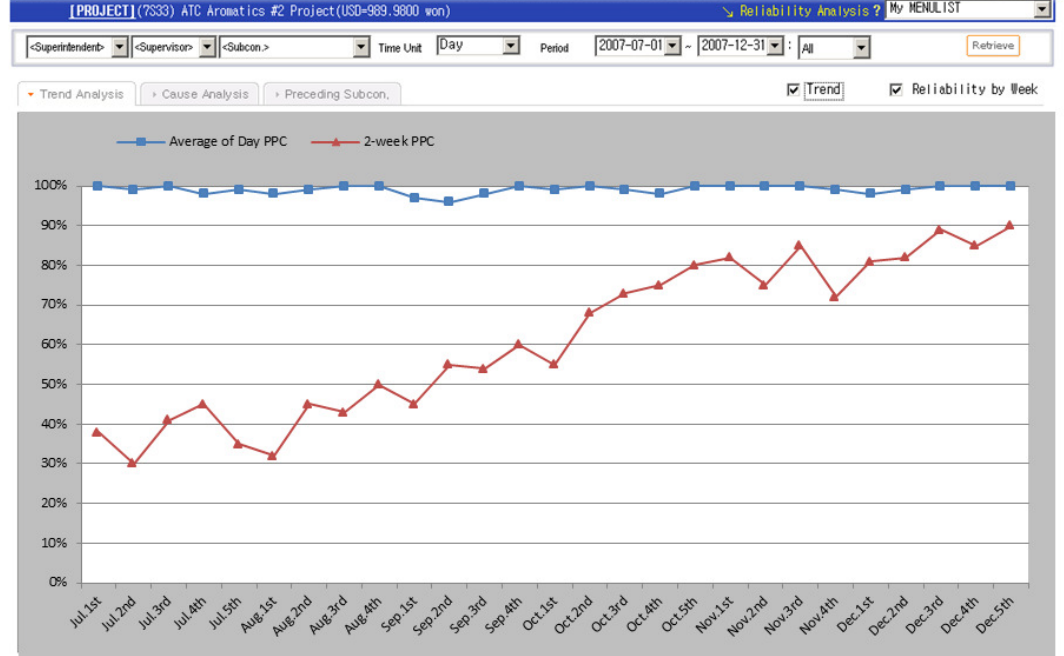
Fig. 9. Planning reliability